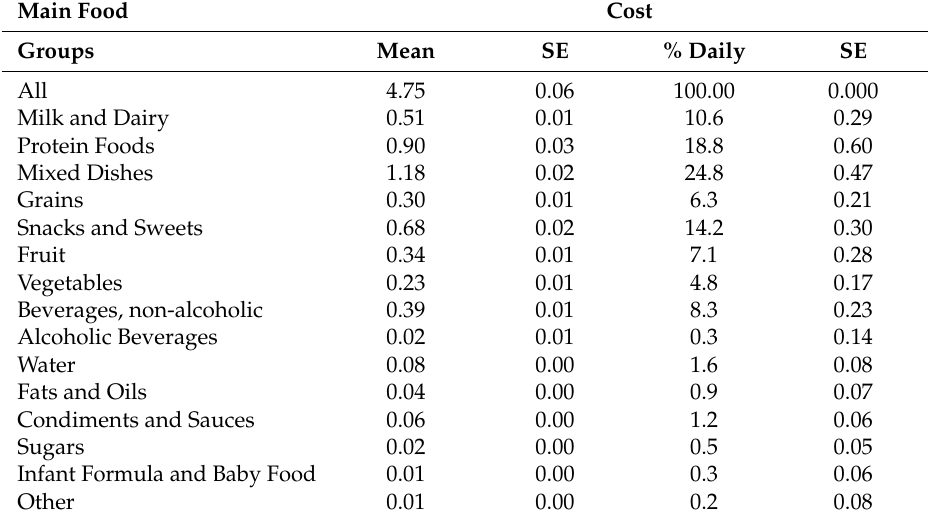
Table 3. Estimated percentage of children, age 2–18 years, who consume specified food groups on a given day, and the estimated mean daily cost ($) of each food group expressed in dollars, and as a percentage of the total cost of food.